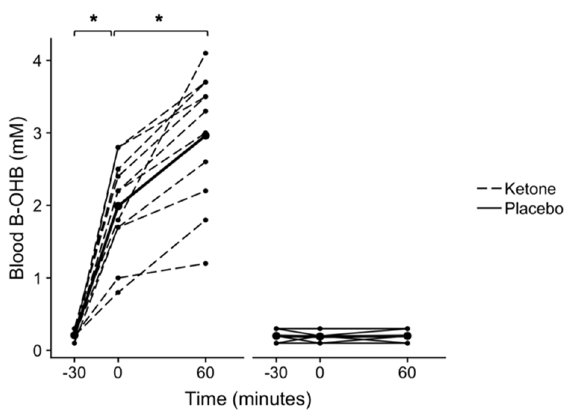
Figure 1. Blood beta-hydroxybutyrate ( β -OHB) following ketone or placebo drink ingestion. Each drink was ingested immediately following the fasted − 30 min blood draw. All timepoints are named relative to the “0 min” time point, at which the OGTT drink was consumed (i.e. − 30 min occurred 30 minutes prior to the consumption of the OGTT drink). A time × condition interaction was found ( p < 0.001). * p < 0.001 Bonferroni-corrected within-condition pairwise comparisons. Individual participant data are shown with the ketone condition represented by dashed lines and the placebo condition represented by solid lines. Means are shown by bold lines with triangles. n = 11.